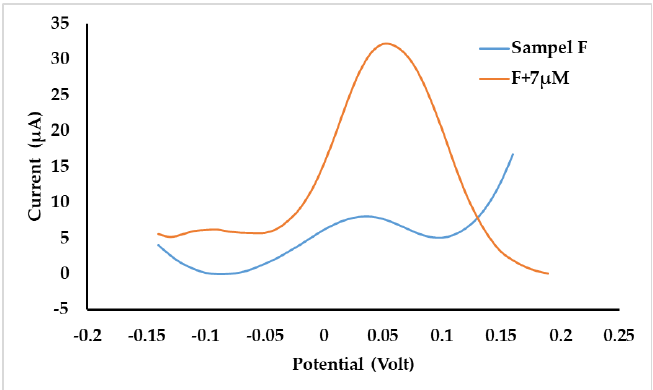
Figure 10. Voltammogram sample F and sample F + 7 µM standard of p -AP.